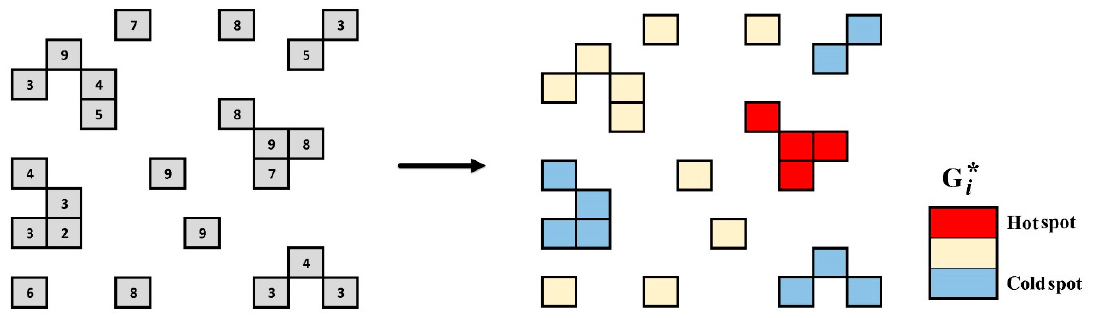
Figure 3. Schematic diagram of hotspot determination using G i* metric.